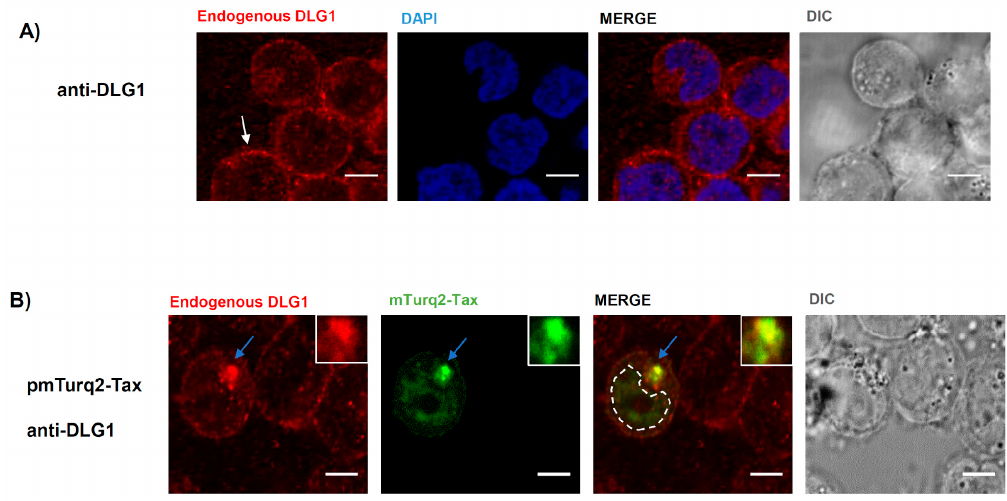
Figure 7. Tax-mediated alteration of DLG1 expression in T-cells. ( A ) Analysis of DLG1 expression in Jurkat T cells. The expression of endogenous DLG1 indicated with white arrows was assayed by immunfluorescence using an anti-DLG1 antibody (red). The nucleus was stained with 4 ′ ,6-diamidino-2-phenylindole (DAPI) (blue); ( B ) Expression of DLG1 in the presence of Tax. Jurkat T-cells were transfected with pmTurq2-Tax and endogenous DLG1 expression was assayed by IF. The light blue arrows indicate the co-localization region (yellow) which is amplified in the inset. All scale bars represent 5 µm.